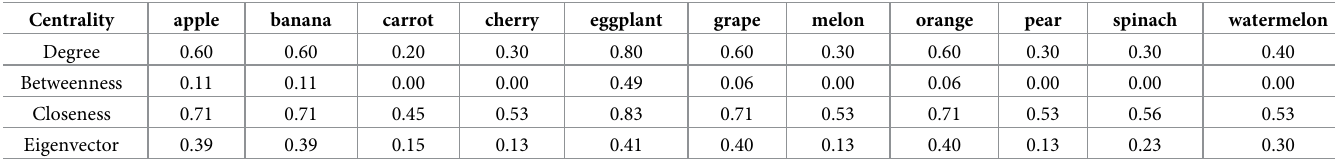
Table 2. Centralities of the words in the network of